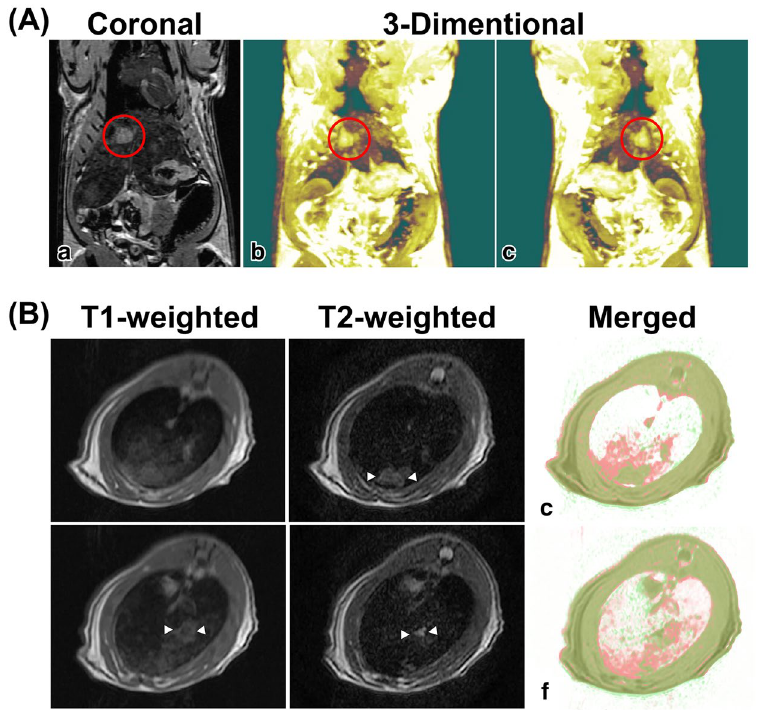
Figure 2. In vivo MRI of LEC rats injected thiol-OS-MNP/Rho. LEC rats (57 weeks) were injected intravenously with 0.9 mL of a solution containing 10 mg/mL of thiol-OS-MNP/Rho. After 1 day, rat was examined on MRI. ( A ) Coronal view (a), 3-dimensional images (b and c) in the 3D-SPGA MRI revealed a large tumor (marked with a red circle) and some small nodules in the liver. ( B ) The T2-weighted MRI (b), but not T1- weighted MRI could detect a nodular high intensity area (marked white triangles) at the same transverse level. At another level, the T1-weighted (c) and T2-weighted (d) MRI showed large nodular area with a moderate intensity and a small nodular area with high intensity, respectively. The T1- and T2-weighted images (a,b and d,e) were merged (c and f, respectively). Some areas in the T1-weighted (red) were identical with the T2- weighted (green) in